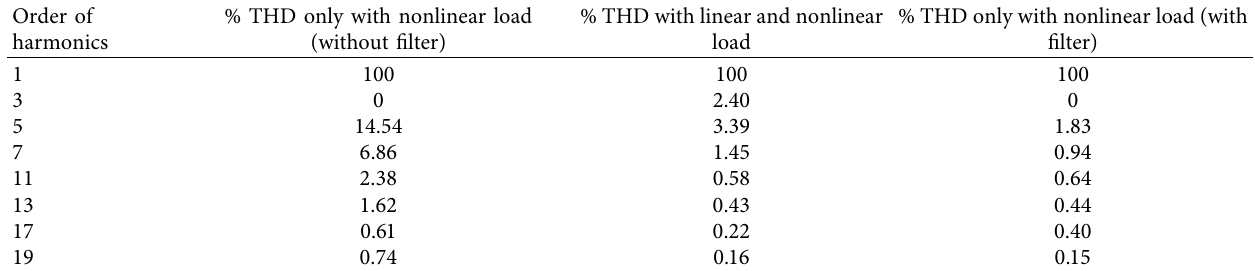
Figure 5: (a) FFT waveform for % THD without MMC-based UPQC, (b)FFT waveform for % THD of with MMC-based UPQC, (c) reference % THD, and % THD of the proposed system. Table 3: % THD of the proposed system with the harmonic